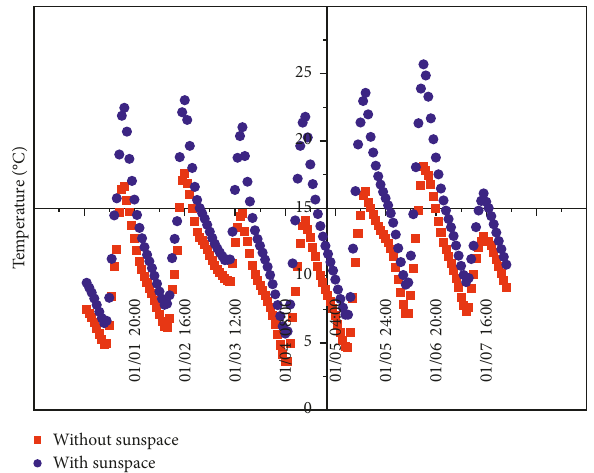
Figure 20: Temperature comparison with and without sunspace mode (source: authors’ own data).